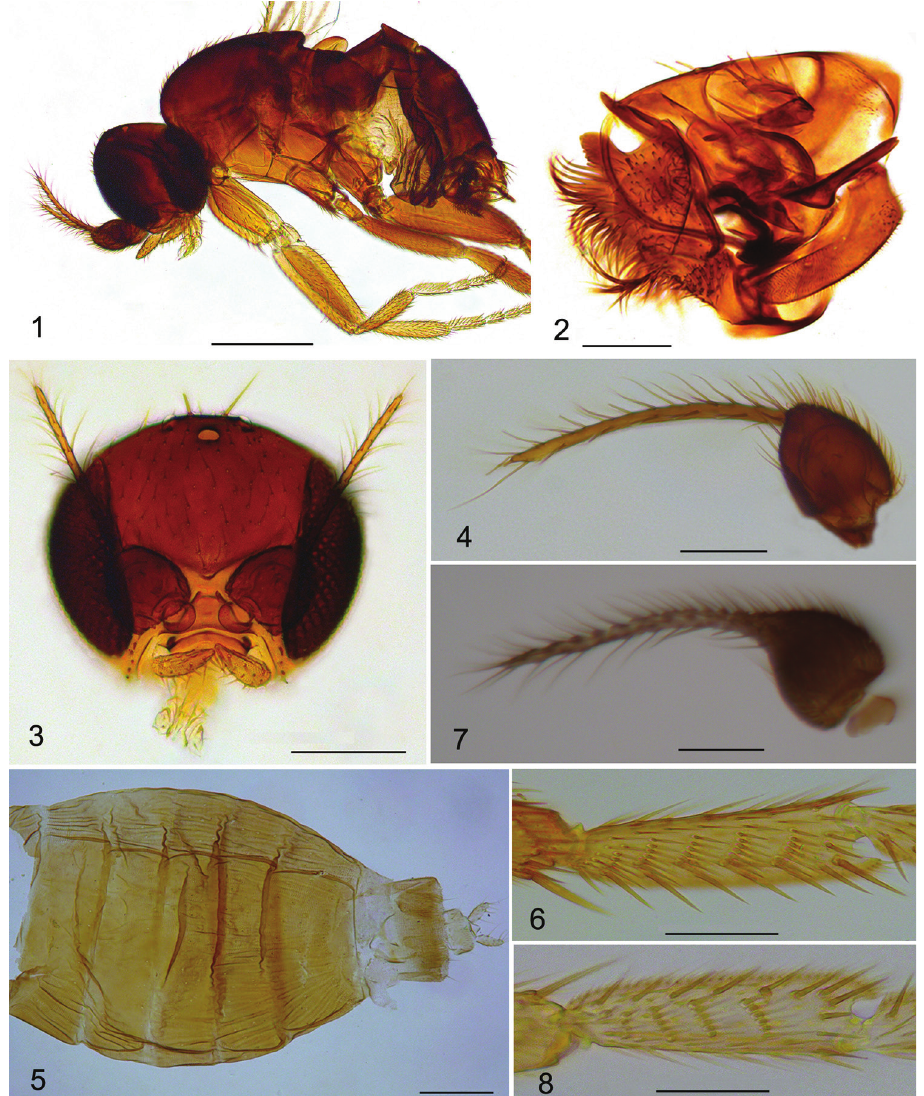
Figures 1–8. Dahliphora species. 1–6 D. chaetocauda . 1 body, male, lateral view 2 hypopygium, pos- terior view 3 head, male, frontal view 4 antenna, male 5 abdominal tergites, female, dorsal view 6 hind metatarsus, male, ventral view 7 D. zaitzevi , male, antenna 8 D. sigmoides , male, hind metatarsus, ventral view. Scale bars 0.2 mm ( 1, 5 ); scale bars 0.05 mm ( 2–4 , 6–8 ).